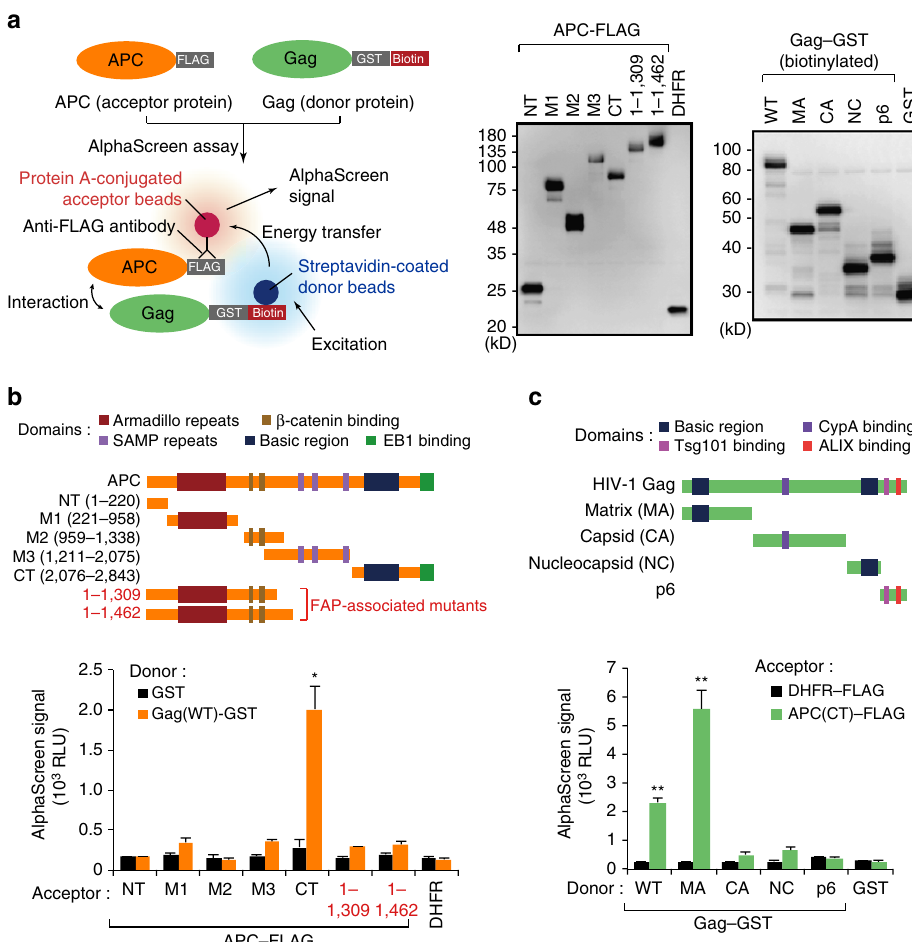
Figure 2 | The C-terminal region of APC interacts mainly with Gag MA. ( a ) Schematic representation of the amplified luminescent proximity homogenous assay (AlphaScreen) used to detect Gag–APC interactions. Gag–GST–biotin with donor beads and APC–FLAG with acceptor beads were mixed. If the two proteins can bind to each other, AlphaScreen signals were detected (left). All recombinant proteins used in the AlphaScreen assay were synthesized using a wheat germ cell-free system and detected by immunoblotting with anti-FLAG antibody and horse radish peroxidase-conjugated streptavidin (right). Full images for all immunoblots are provided in Supplementary Fig. 4. ( b , c ) AlphaScreen assays with recombinant APC truncated mutants ( b ) and Gag domains ( c ). FLAG–DHFR (dihydrofolate reductase) and GST were used as negative controls. All graphs are presented